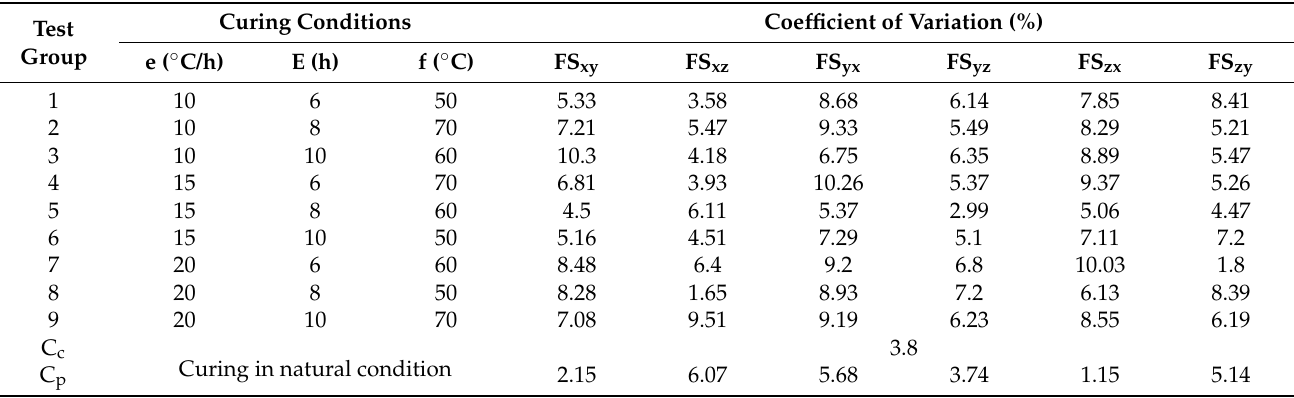
Table 9. Orthogonal experimental table of various test group designs, curing conditions, and variation coefficient of flexural